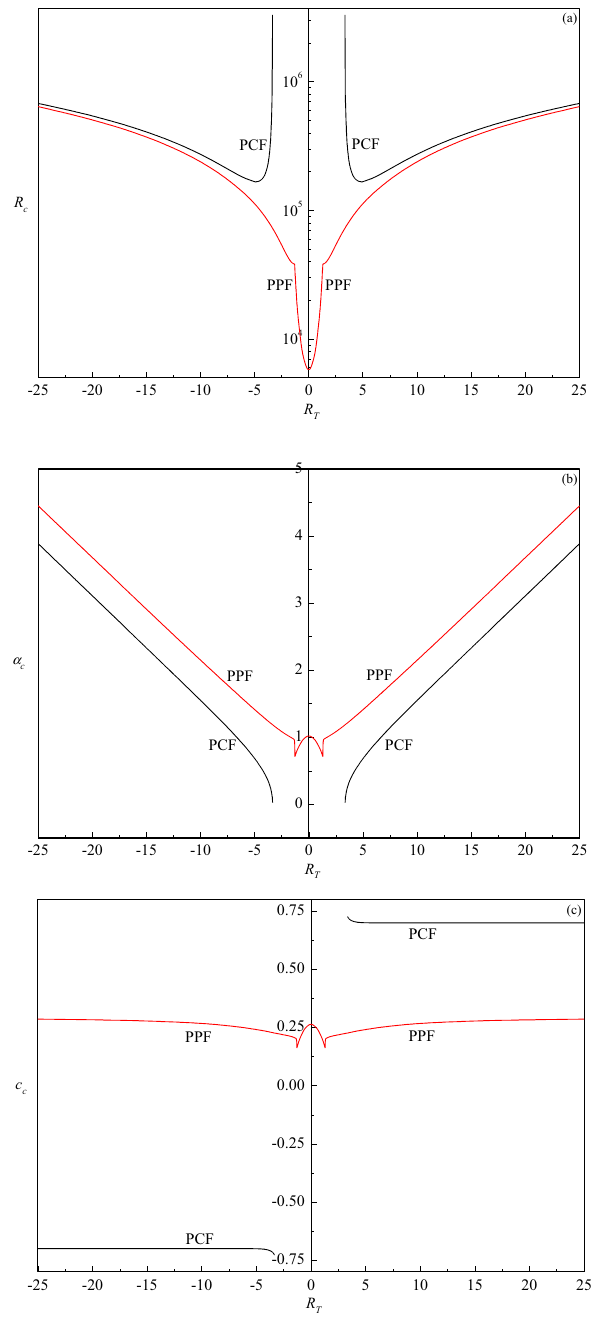
Figure 6. Plots of ( a ) R c , ( b ) α c and ( c ) c c as a function of R T for the plane Couette flow (PCF) and plane Poiseuille flow (PPF).